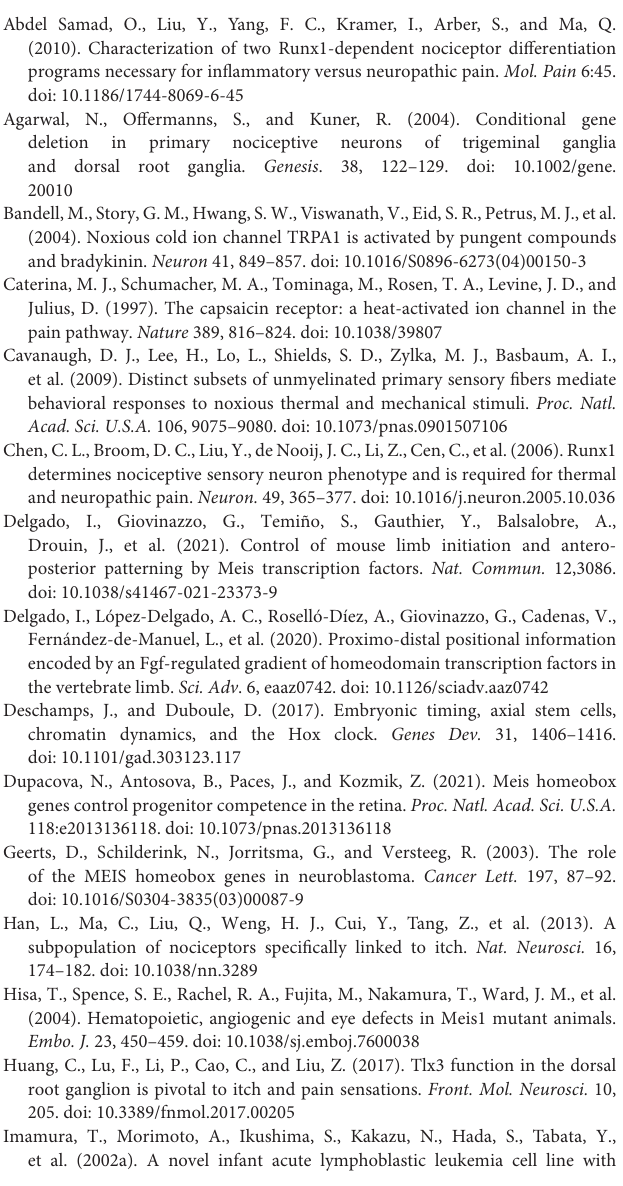
Supplementary Figure 3 | Meis1 + neurons coexpressed Meis2 at different stages. Representative images of lumbar DRG sections costained with the Meis1 mRNA (green) and Meis2 mRNA (pink) in Meis1cko and control mice at different stages. Nearly all Meis1 + neurons coexpressed Meis2. DAPI-stained cell nuclei appeared blue. Scale bar: 50 µ m. Supplementary Figure 4 | Expression of Trpa1 and Trpv1 was similar between control and Meis1cko DRG. (A–C) Trpa1 expression on T13 DRG ( n = 3), (D–F) Trpv1 expression on L4 DRG ( n = 3). Scale bar: 50 µ m. Supplementary Figure 5 | Distinct cluster marker expression patterns at different axial levels. (A–X) ISH with the indicated probe on sections through C6/C7, T7/T8